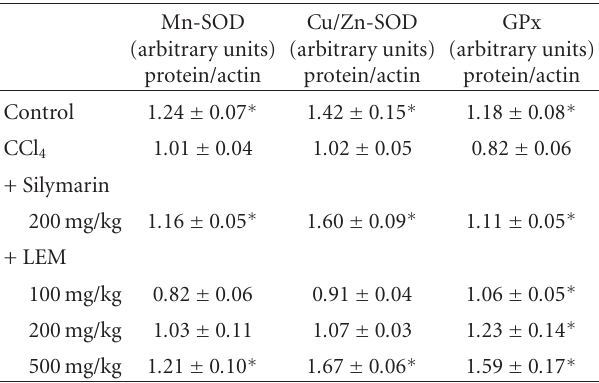
Table 2: The quantification of protein levels for Mn-SOD, Cu/Zn- SOD, GPx, or actin in liver isolated from CCl 4 -induced rats receiving treatment with silymarin or LEM three times daily for 8 weeks. Quantification of protein levels using Mn-SOD/actin, Cu/Zn-SOD/actin, and GPx/actin was expressed as mean with standard error (SE) ( n = 4 per group) in each group. ∗ P < 0 . 05 compared with CCl 4 -induced group receiving